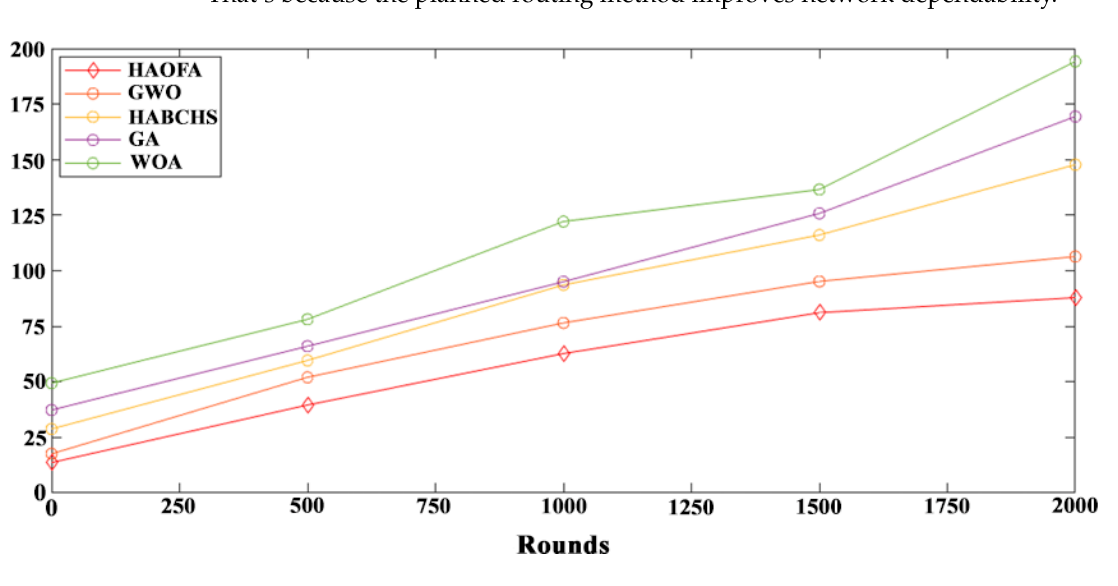
Figure 1. Total energy consumption.